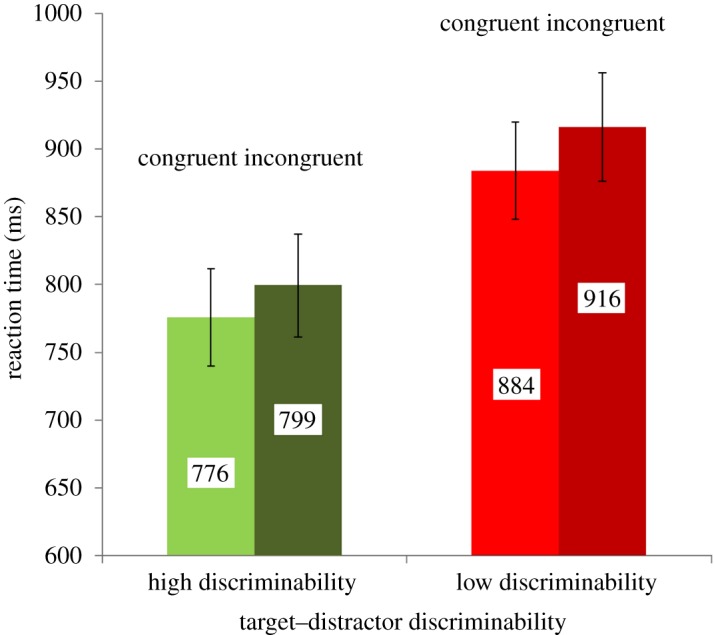
Manual reaction time as a function of congruency and target–distractor discriminability. Error bars represent standard errors of the mean.